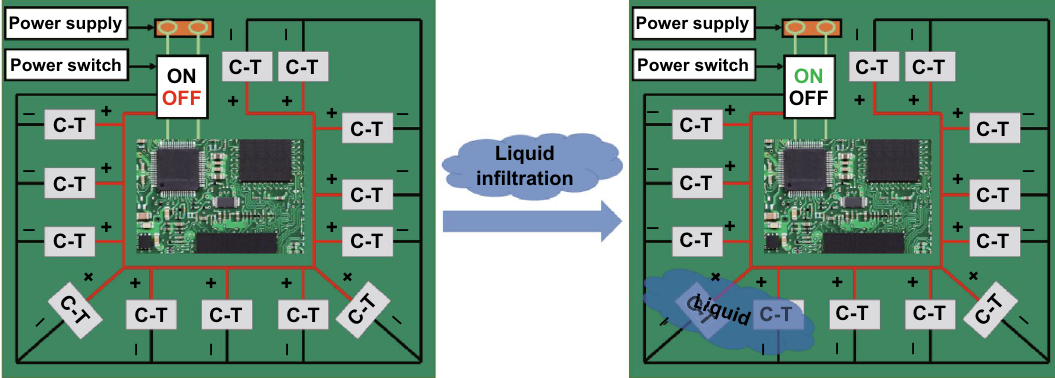
Fig. 6 Schematic of a possible system for PCB protection using an array of C-T